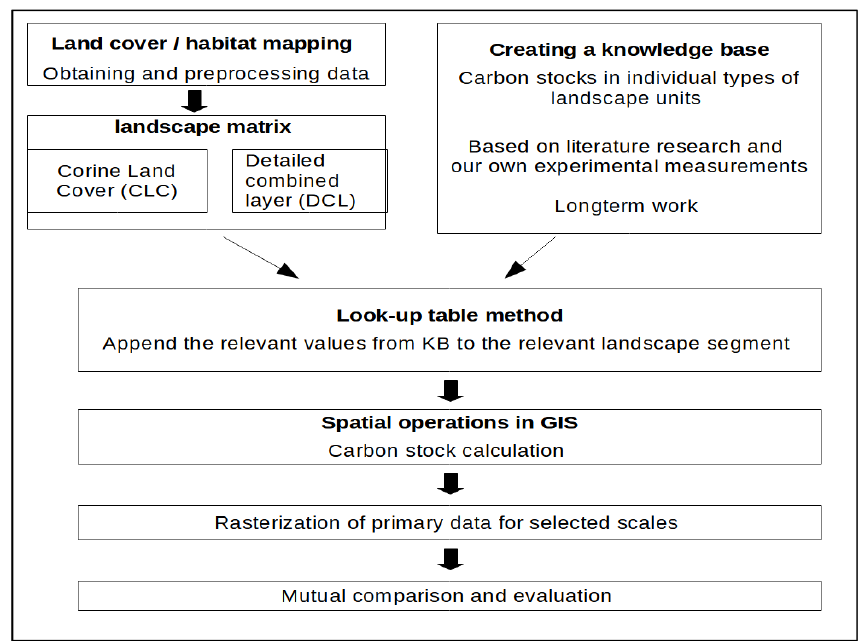
Figure 3. Overview of the used methodology (detailed description in the text).